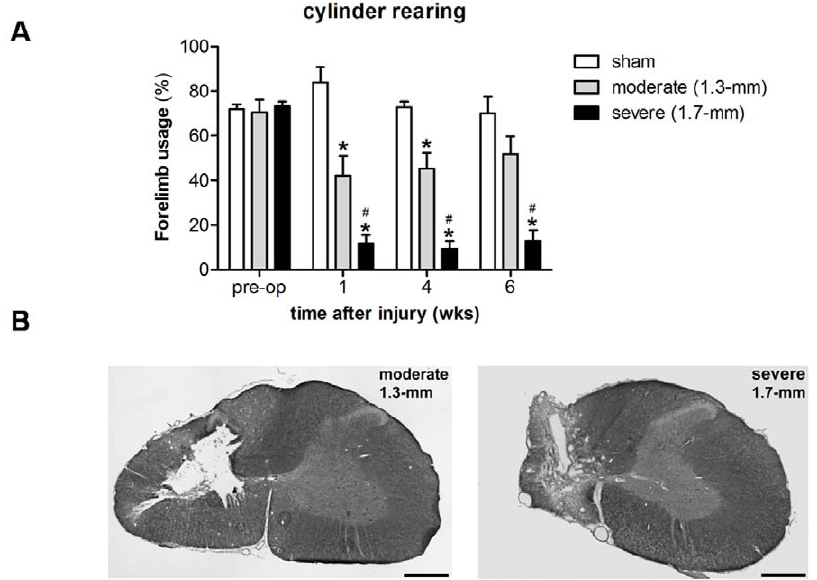
Figure 2. Injury assessment. (A) Influence of 1.3-mm and 1.7-mm displacement injuries at C5 on forelimb usage during rearing. A contusion injury with a tissue displacement of 1.3-mm produced a ‘mild’ injury with forelimb motor deficits that recovered over time. The more ‘severe’ 1.7-mm displacement injury produced nearly complete loss of forelimb usage that was sustained until the end of the study. Error bars indicate standard error of the mean (SEM). ‘‘*’’ significantly different from sham group, p # 0.05; # 1.7-mm groups significantly different from 1.3-mm group, p # 0.05. (B) Histological outcome to the spinal cord following contusion injury with 1.3-mm or 1.7-mm tissue displacement 6–10 weeks after injury. Example image of eriochrome cyanine- and neutral red-stained coronal section of the injury at the epicenter. Scale bar: 500 m m.